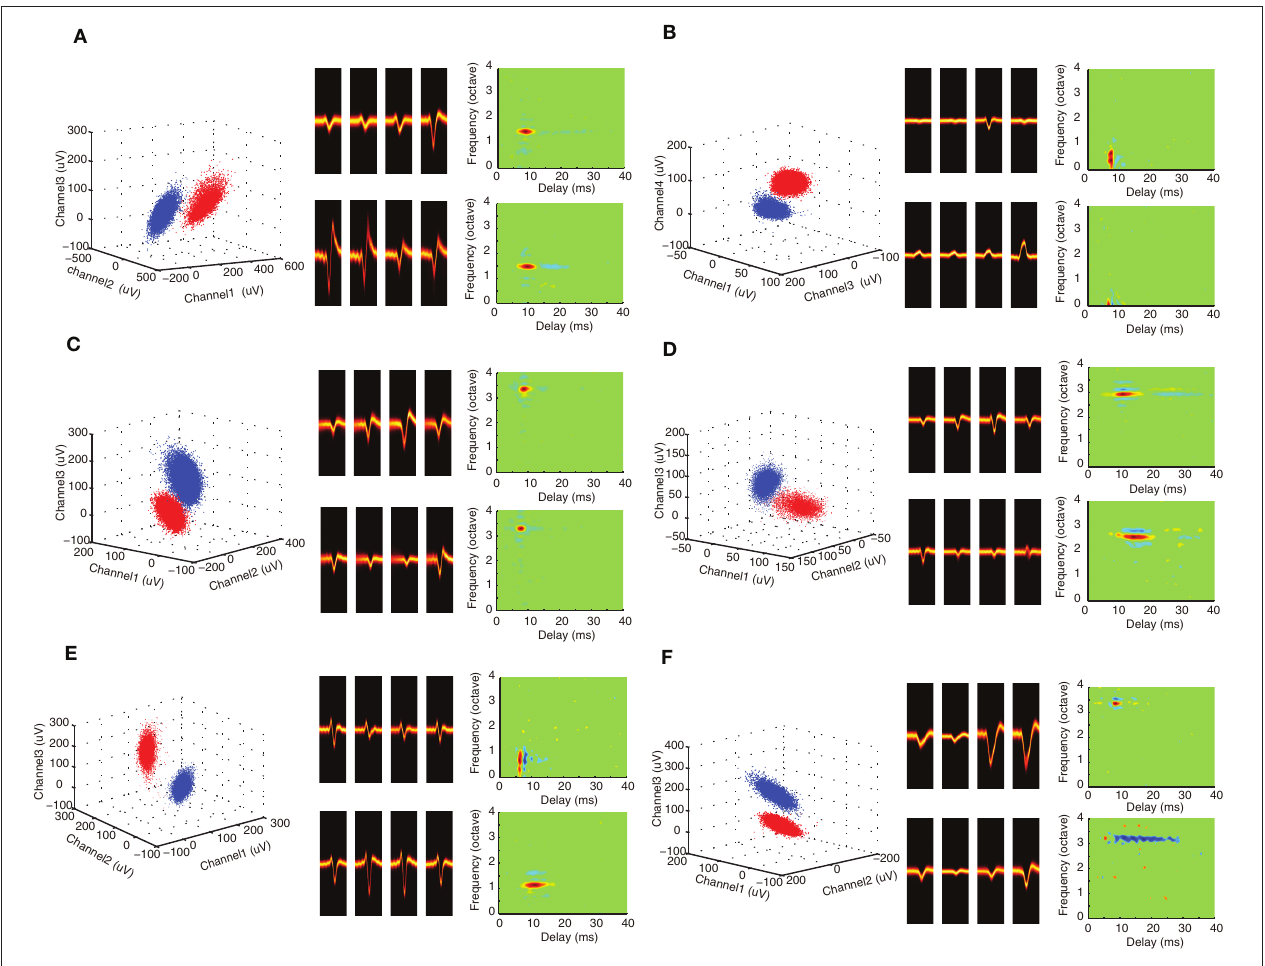
FIGURE 2 | Spectrotemporal selectivity of neighboring single neurons. (A–F) Example single unit waveforms and the corresponding STRFs are shown for neighboring neurons. All of the examples follow the same format as Figures 1C,D . For each unit, the waveform peak amplitude clusters are shown ( left , selected tetrode channels) along with the spike waveform density plots for the isolated units ( middle ). STRFs are shown on the right two panels for each isolated single unit example. Red colors indicate that the sound tended to be on prior to the occurrence of an